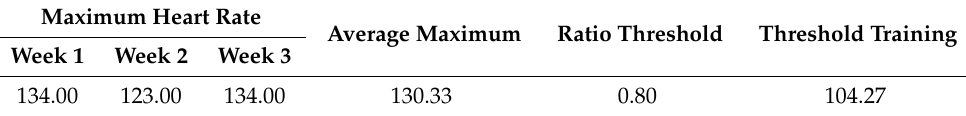
Table 4. Parameters for determining a threshold training.